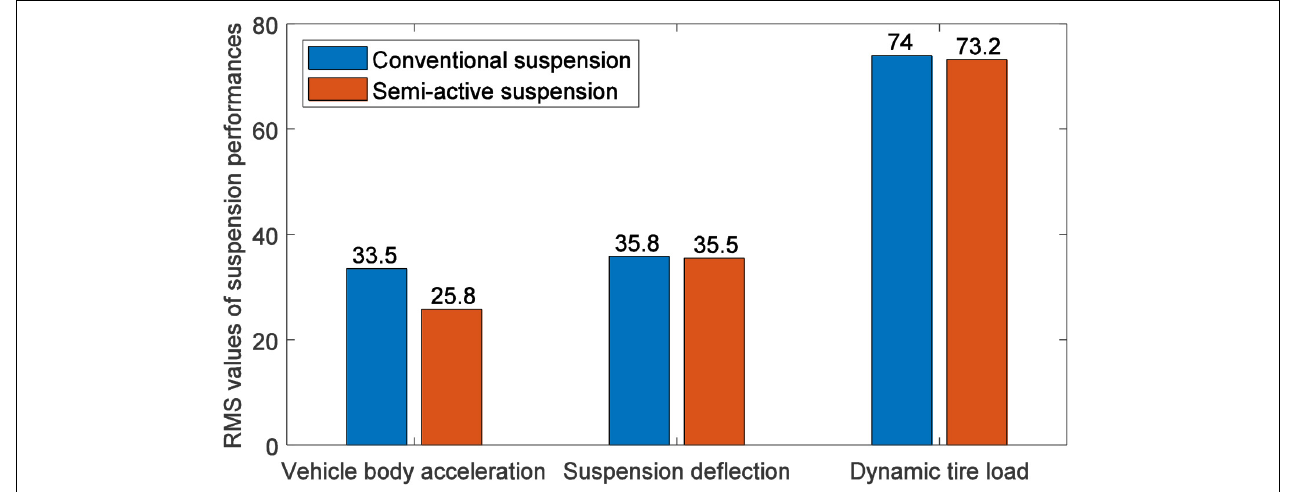
FIGURE 14 | Root mean square values of the suspension